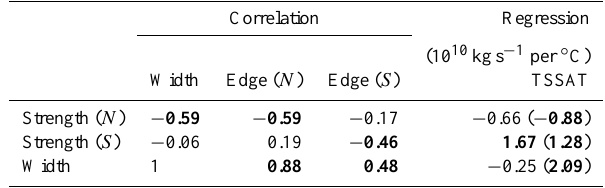
Table 1. Correlations between the strength, width and edge of the Hadley Circulation, and regressions of the strength and width of the Hadley Circulation on the averaged 20CR2 surface air temperature in the tropics and subtropics (TSSAT). Correlation